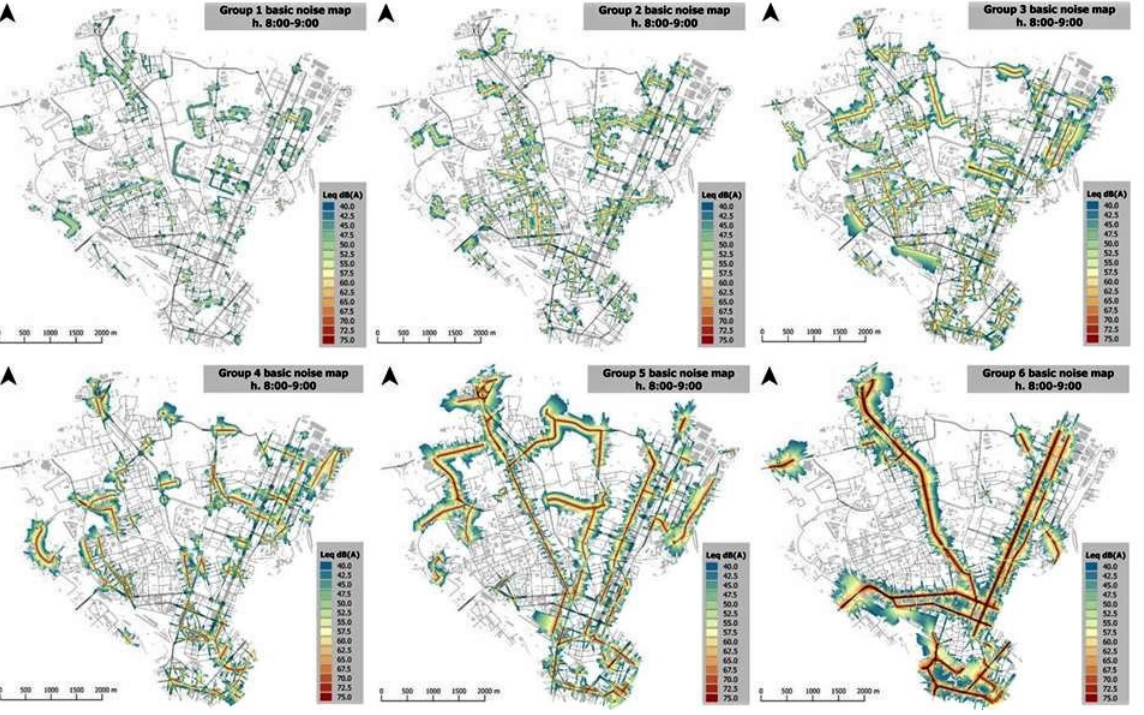
( 1h ) ( t ) , for all road stretches s belonging to each group g eq ref , s